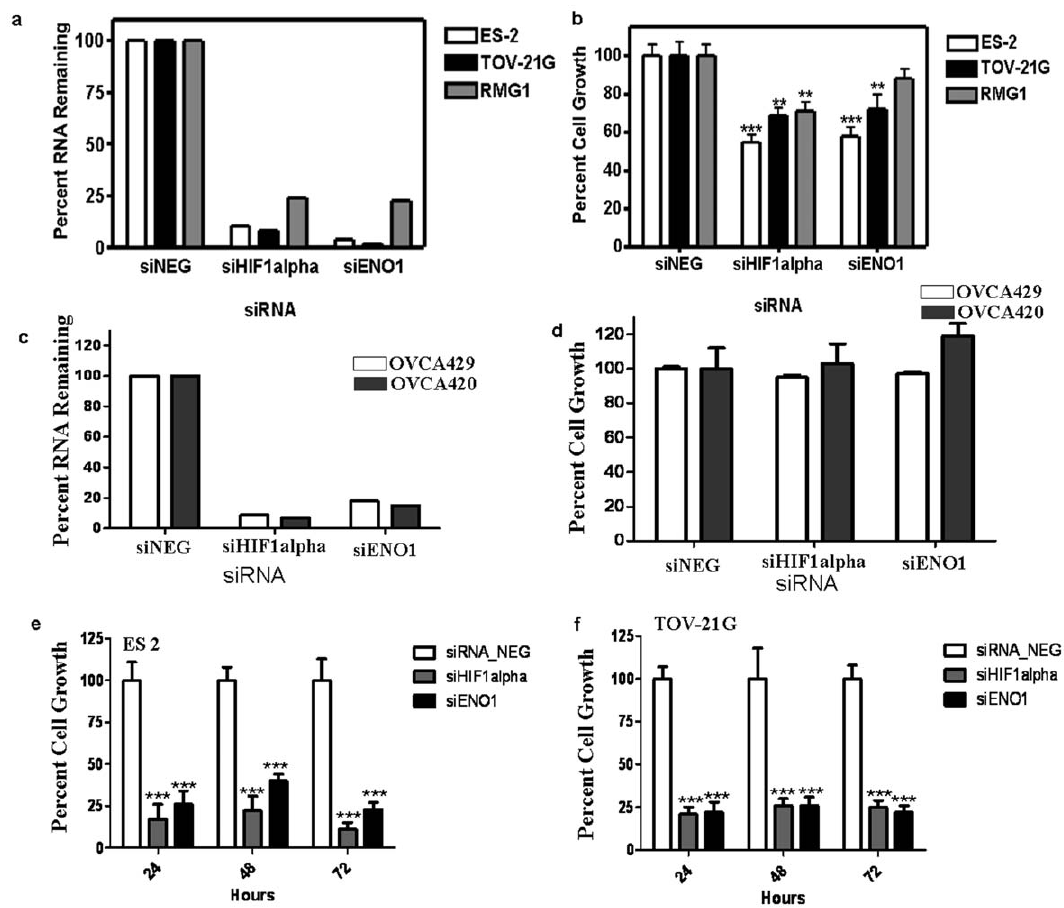
Figure 3. Knockdown of HIF1 a and ENO1 in three clear cell ovarian cancer cell lines. ( a ) Knockdown efficiency of siRNA molecules targeting HIF1 a and ENO1 in three clear cell ovarian cancer cell lines, assessed by quantitative real-time PCR. ( b ) The percent of growth inhibition after transfection of siRNA molecules targeting HIF1 a and ENO1. Growth was assessed after 24 hours of hypoxia/glucose deprivation *p=0.12, **p , 0.05,***p= , 0.0001. (c, d) Knockdown efficiency of siRNA molecules targeting HIF1 a and ENO1 in OVCA429 and OVCA420 and the percent of growth inhibition after transfection of siRNA molecules targeting HIF1 a and ENO1. (e, f) Effect of HIF1 a and ENO1 knockdown on proliferation of ES-2 and TOV-21G clear cell cell lines (***p= ,